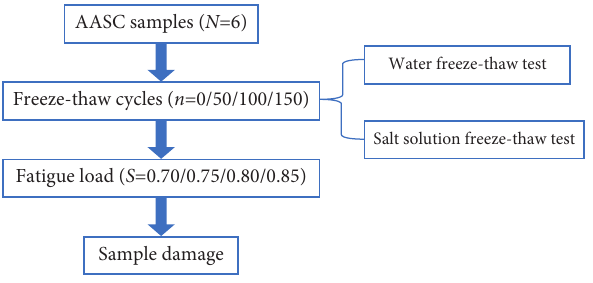
Figure 3: Flow chart of coupling experiment. Table 4: Flexural fatigue lives of undamaged AASC samples.